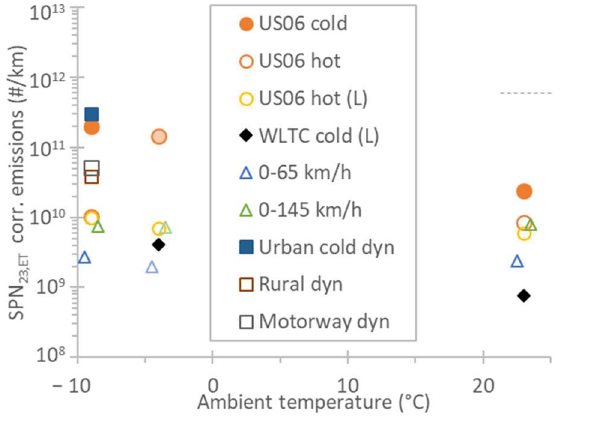
Figure A2. Accelerator pedal position and engine load for the US06 test at −4 °C.